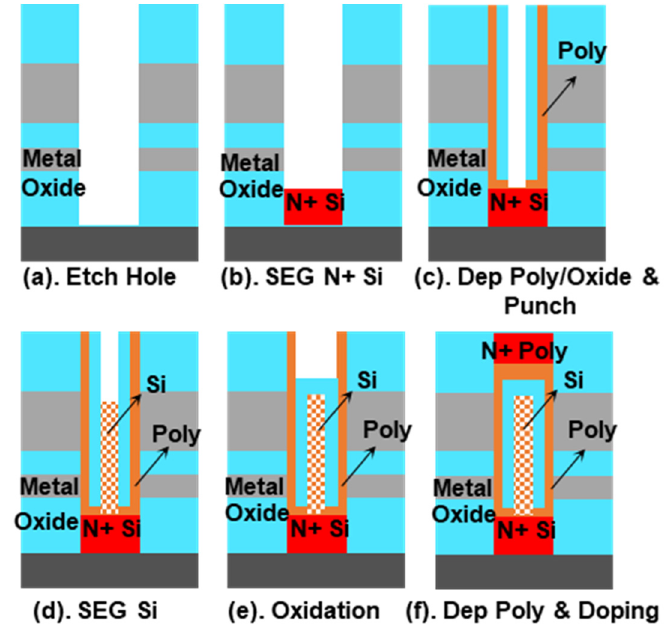
Figure 1. The structure of the conventional DFM and the novel proposed structure of the capaci- torless 1T DRAM with embedded oxide layer.